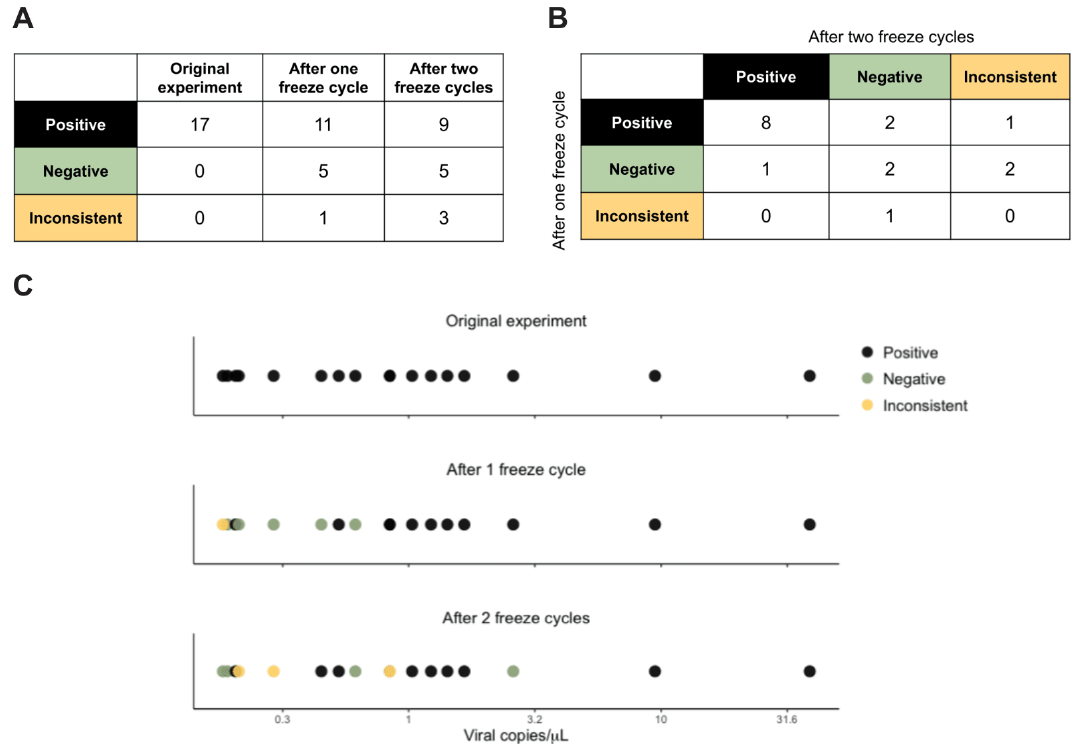
Figure 4. Reproducibility of results among the 17 Neg_Pos samples. ( A ) Summary of the microfluidic qPCR results across the original experiment and two replication experiments (after one freeze cycle and after two freeze cycles). ( B ) Cross-tabulation of microfluidic qPCR results in the two replication experiments. ( C ) Viral load estimates for the 17 Neg_Pos samples based on the original experiment. Color coding is based on the microfluidic qPCR results of the 17 samples in the two replication experiments, as either positive (black), negative (green), or inconsistent (yellow).